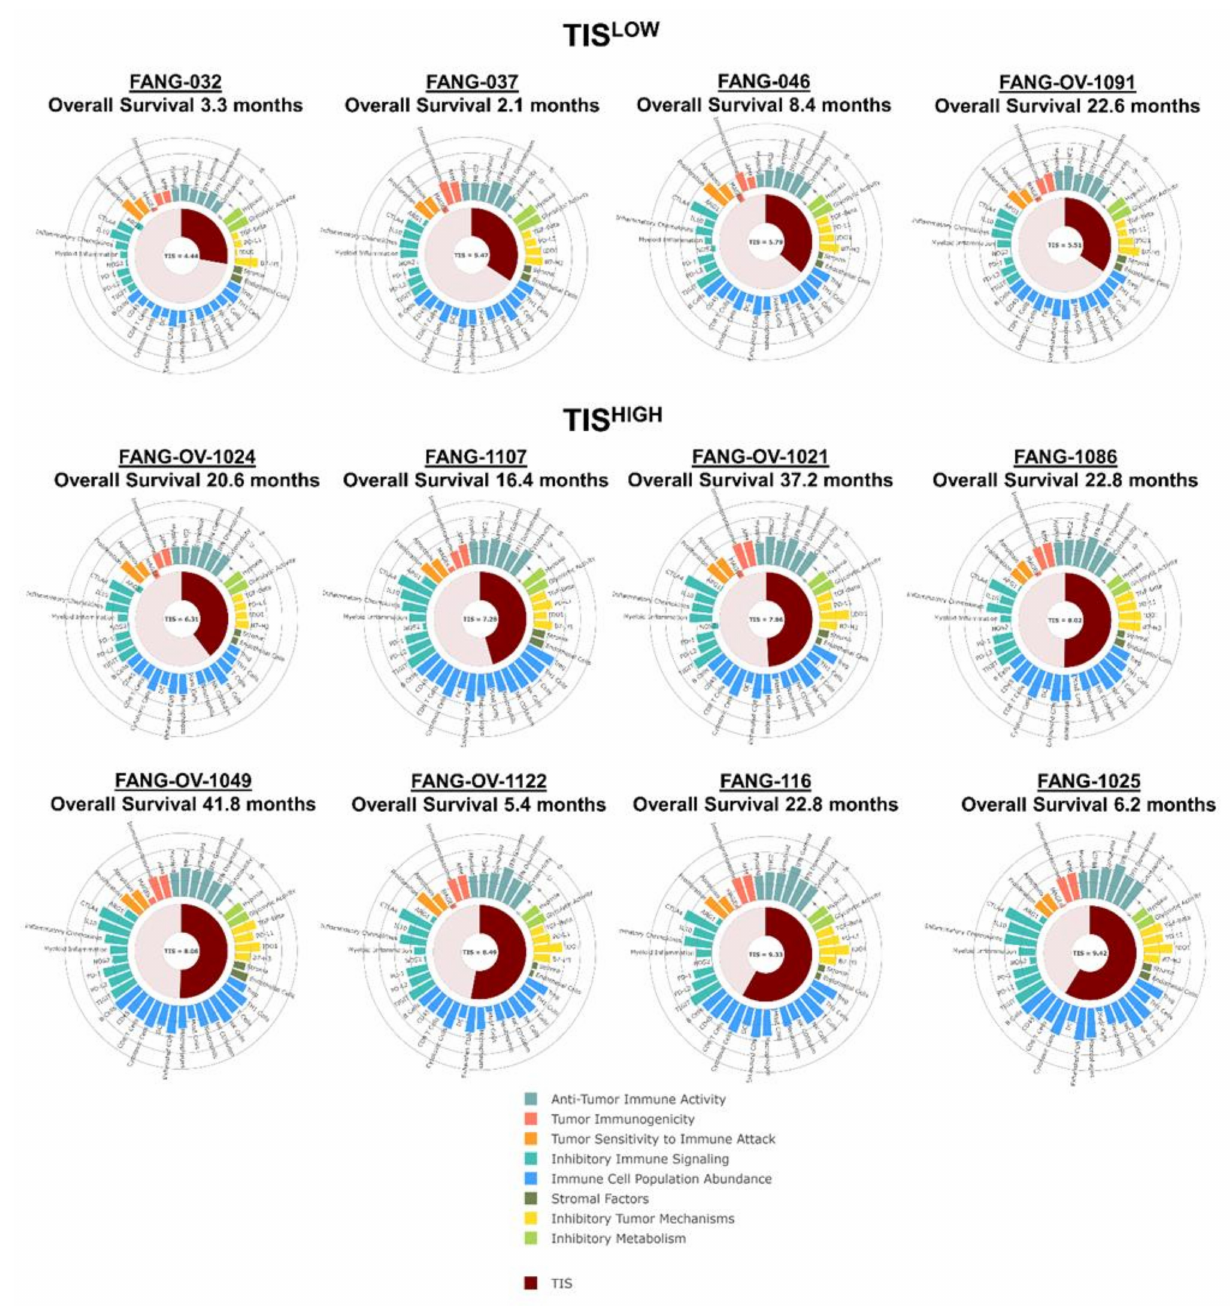
Figure 5. Patient tumor inflammation score (TIS) scores and relationship with survival and immune